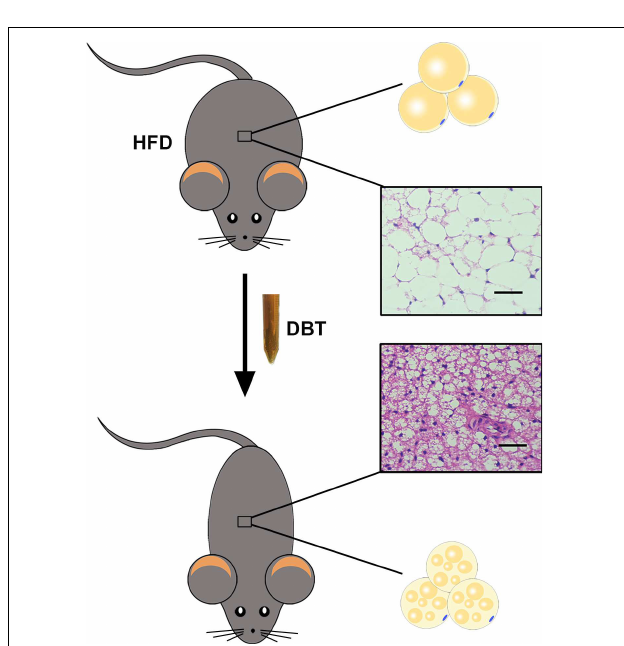
FIGURE 6 | DBT treatment reduced adipose tissue weight and the size of adipocytes by activating